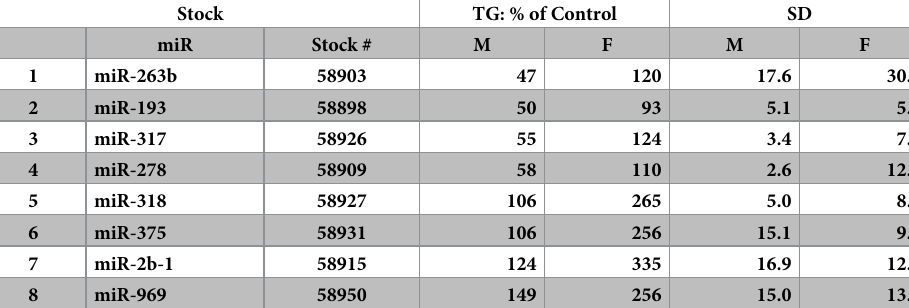
Table 3. Heterozygote microRNAs regulating body